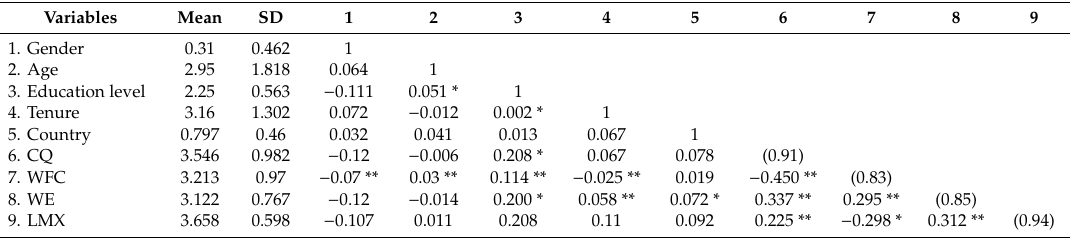
Table 1. Descriptive statistics and correlations among study variables.